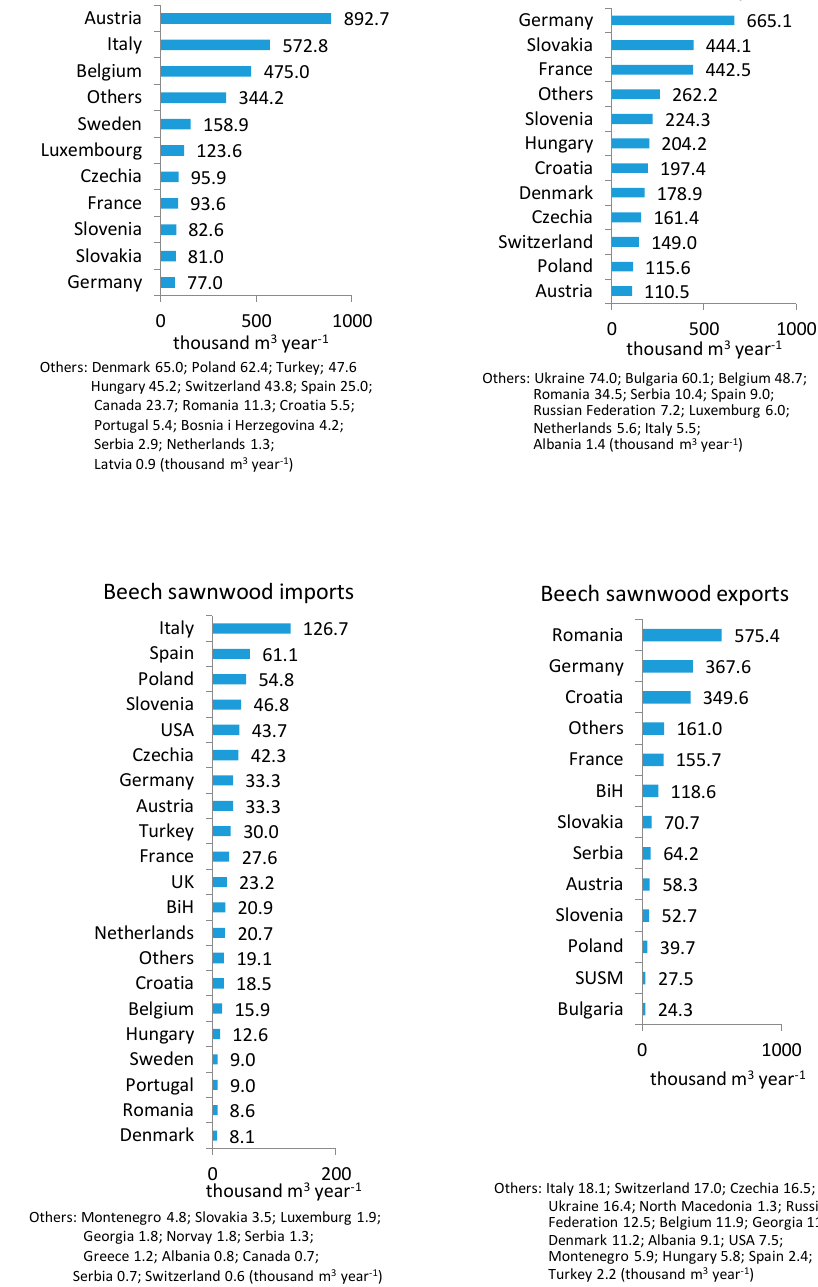
Figure 1. Volume of beech roundwood and sawnwood exports and imports by country in the years